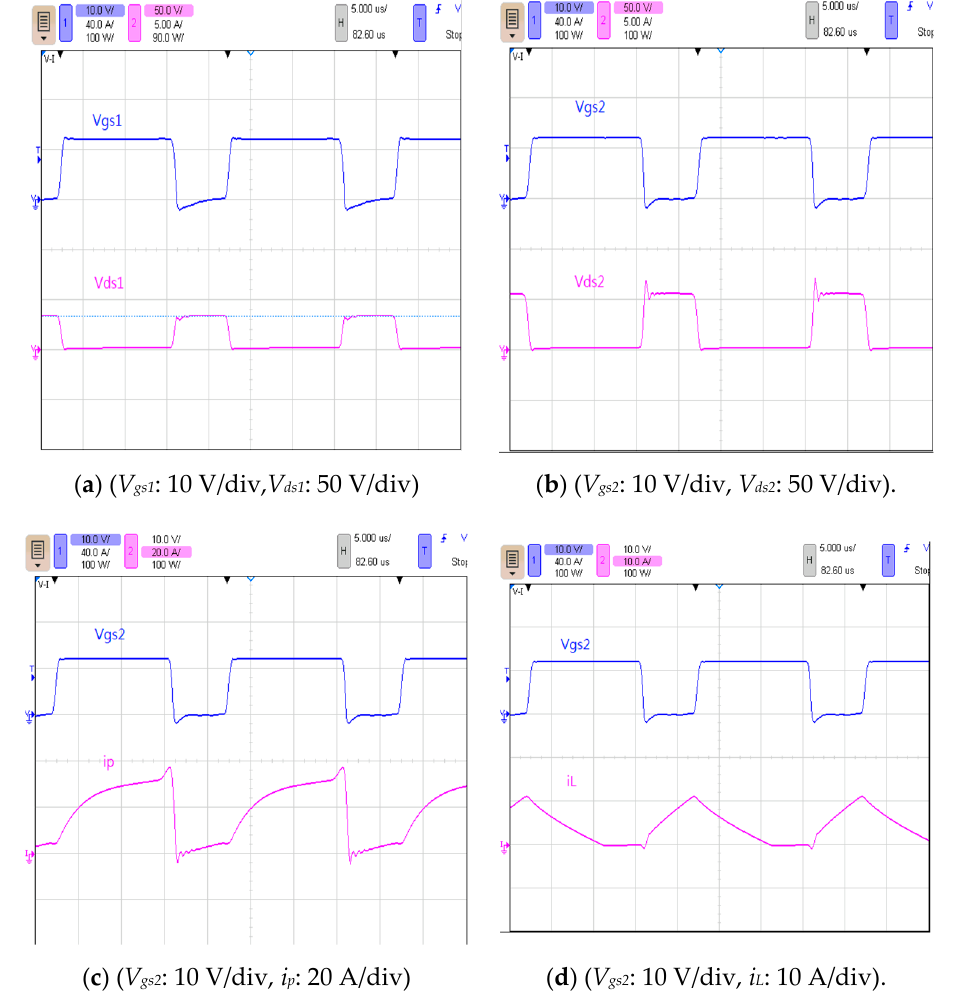
19 of 25 Figure 11. Measured waveforms under Stage 2 at half load: ( a ) switch S 1 waveform, ( b ) switch S